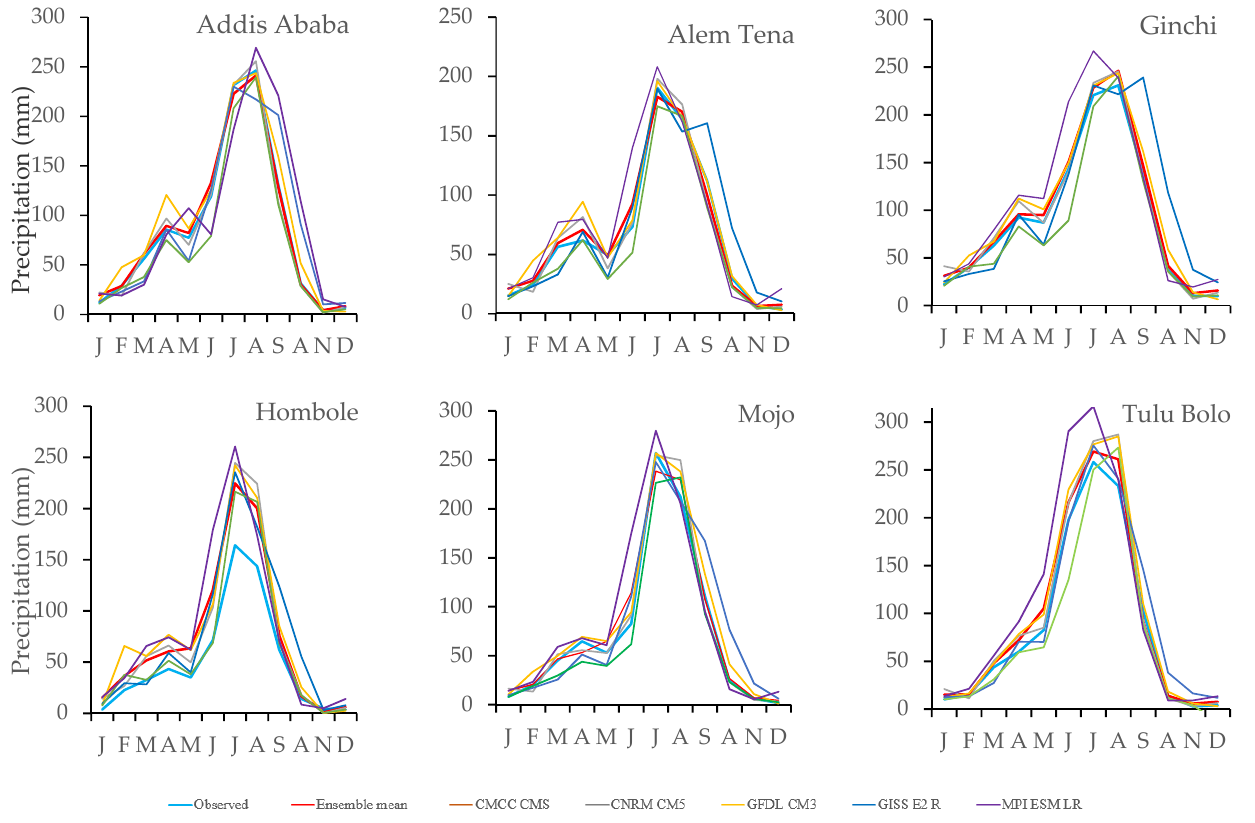
Figure 5. Mean monthly precipitation for the baseline and each GCM for six meteorological stations.